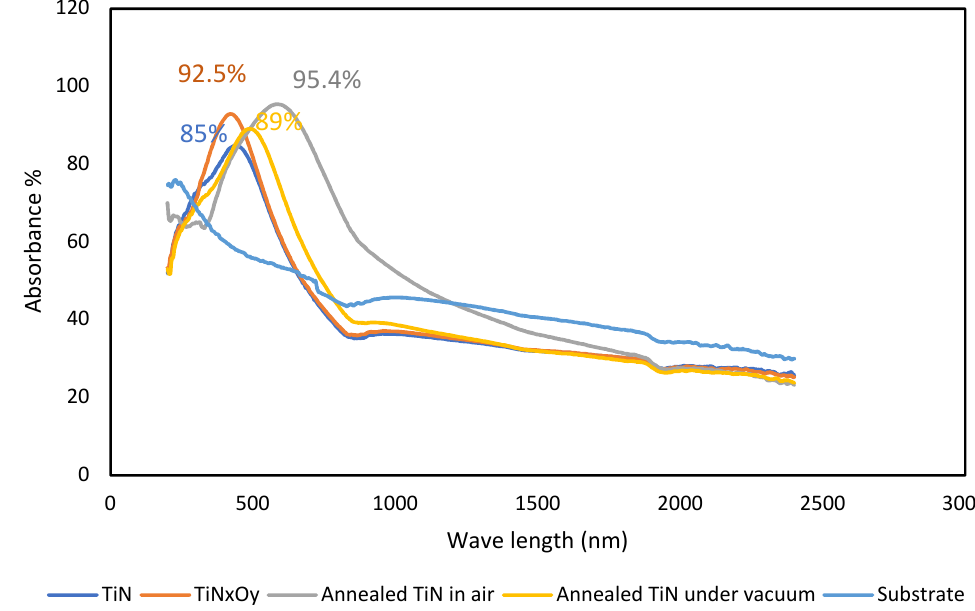
Figure 4. Absorbance of TiN, TiN x O y , annealed TiN in air, and vacuum.